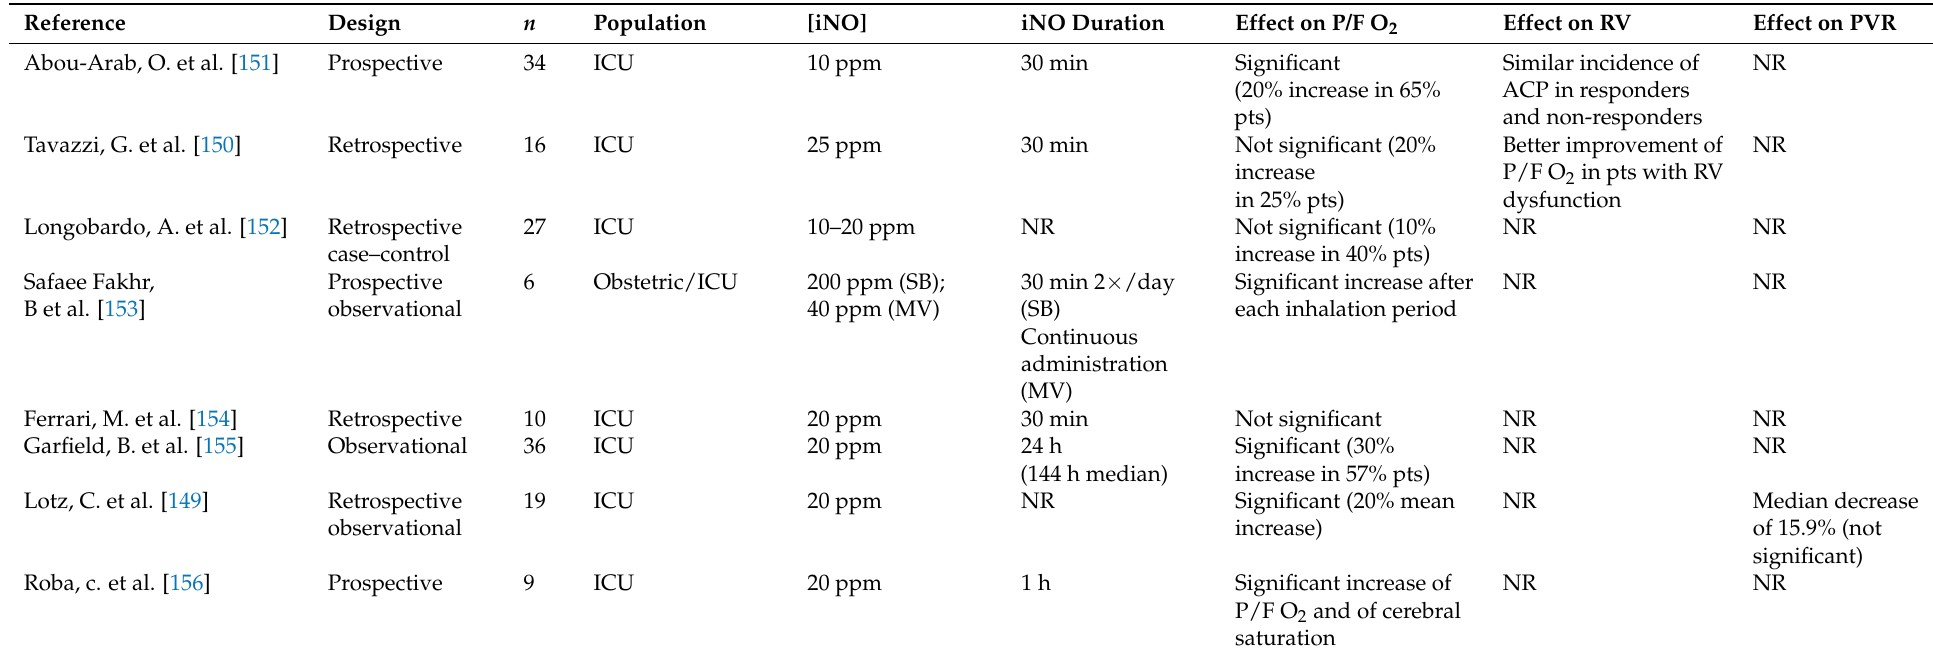
Table 4. Summary of studies investigating inhaled nitric oxide in